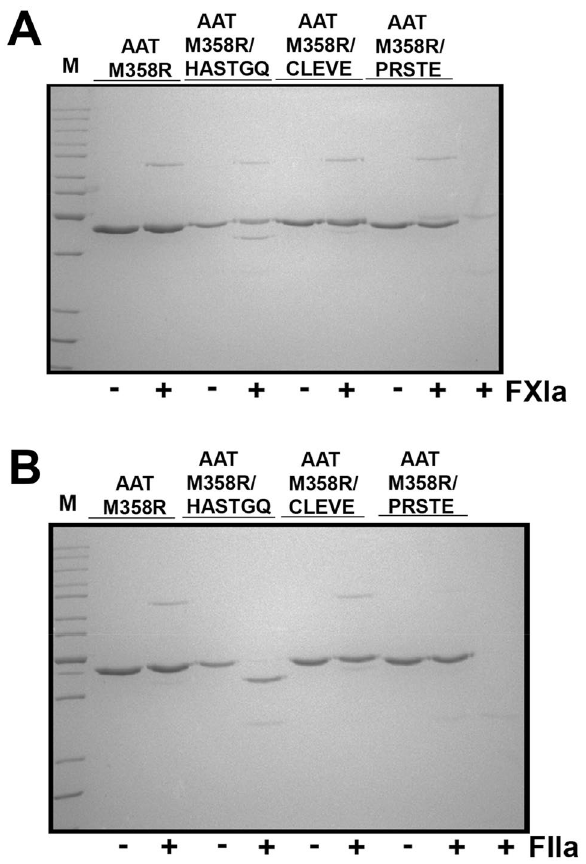
Figure 3. Reactions of AAT M358R and variants with RCL substitutions comprising motifs 1–3 with FXIa and thrombin. AAT variants (at 1.0 µM, identified above the lanes) were incubated at 37 °C for one minute with ( +) or without ( −) 0.1 µM FXIa (Panel A ) or five minutes with ( +) or without ( −) 0.1 µM FIIa (Panel B ) prior to SDS-PAGE under the same conditions and with the same markers as in Fig. 2.